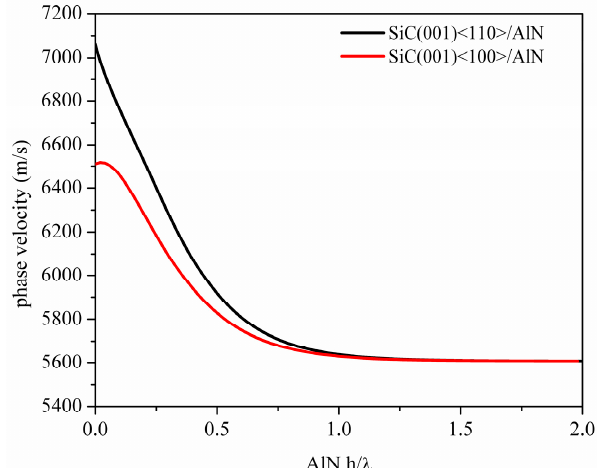
Figure 12. The phase velocity dispersion curves of the Rayleigh-like waves propagating along 3C-SiC(001)<100>/c-AlN and 3C-SiC(001)<110>/c-AlN structures.